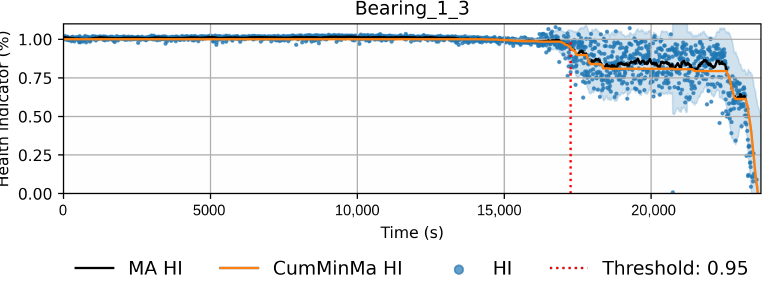
Figure 13. Health index predictions for bearing 1_3. Intervals as the +/ − 1 running standard deviation.